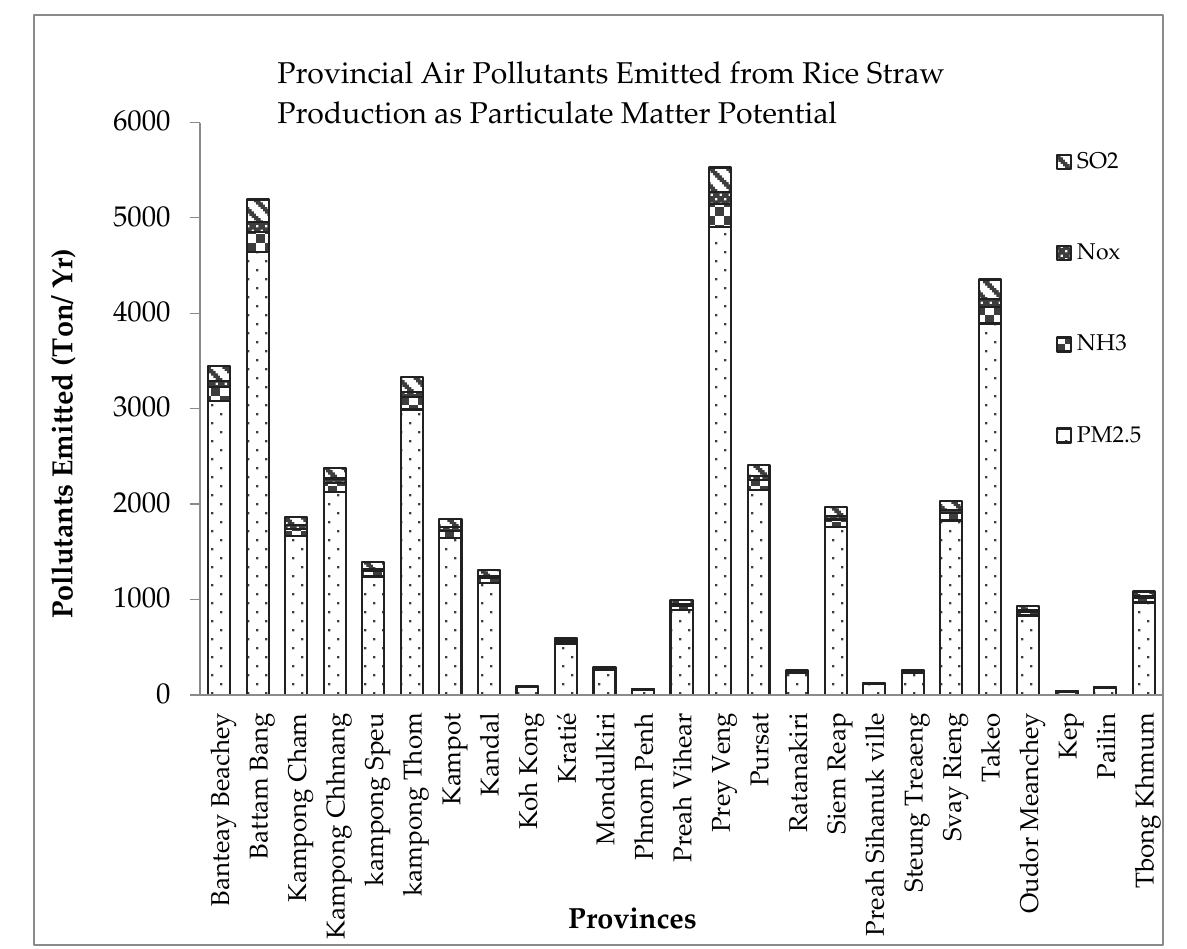
Table A2. Prey Veng was the top province where produced pollutants from rice production and followed by Battam Bang and Takeo province that have shown in Figure 3.